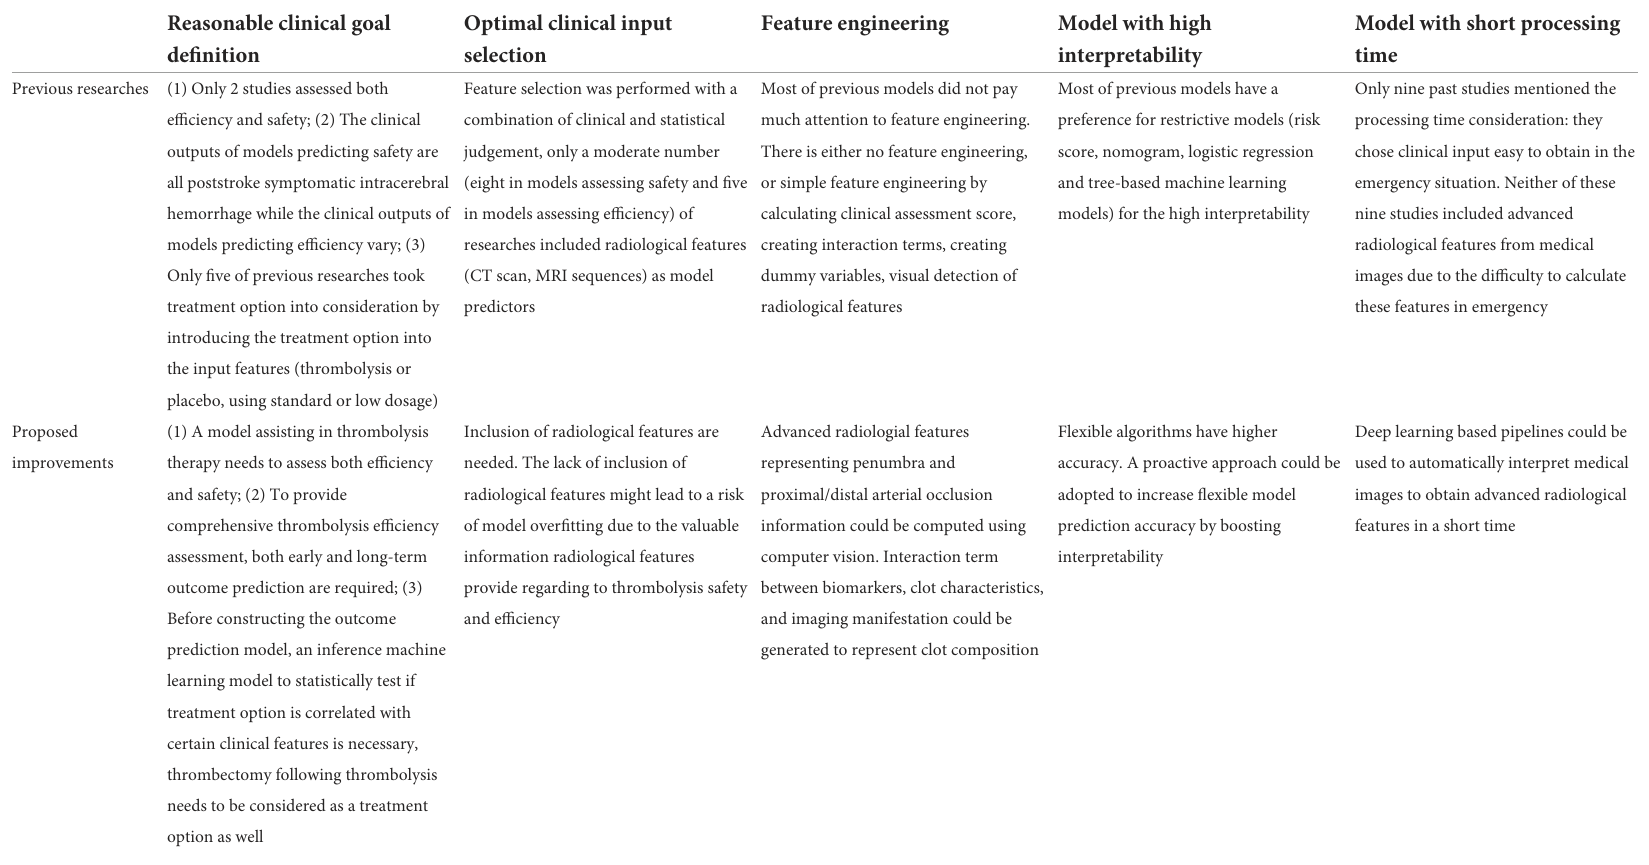
TABLE 1 Summary of previous studies in terms of the five criteria a machine learning model should meet in order to be accurate and feasible in assisting thrombolysis therapy (Figure 2), as well as the corresponding proposed